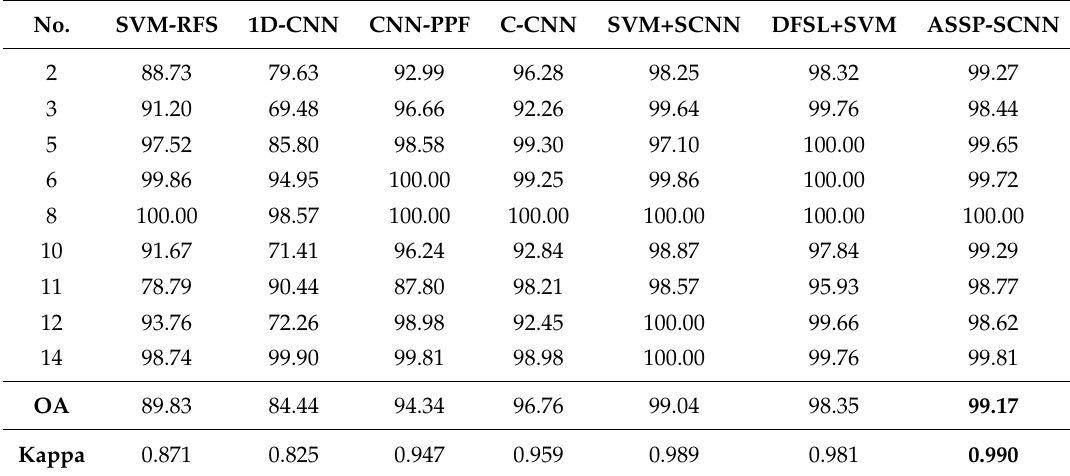
Table 8. Class-specific accuracy (%), OA (%) and Kappa coefficient of ASSP-SCNN and the comparing methods on Indian Pines dataset with nine classes.